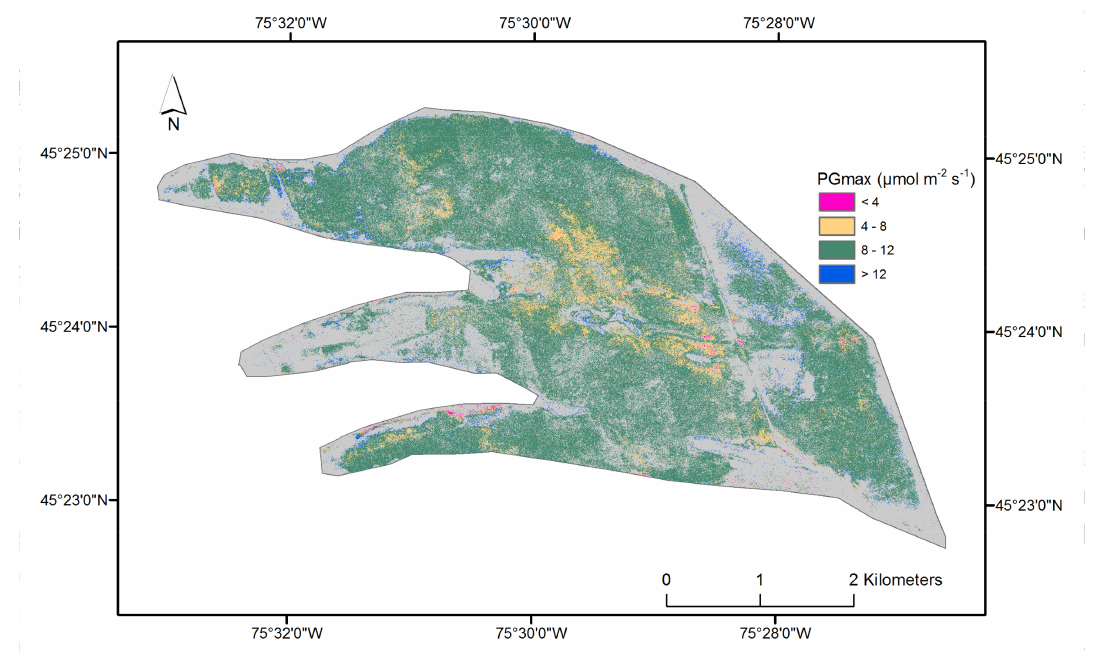
Figure 6. Spatial distribution of maximum gross photosynthesis (PGmax) for hummock surfaces at Mer Bleue based on CASI imagery from 23 June 2016. Areas in grey include hollows and treed areas not included in the PGmax analysis.